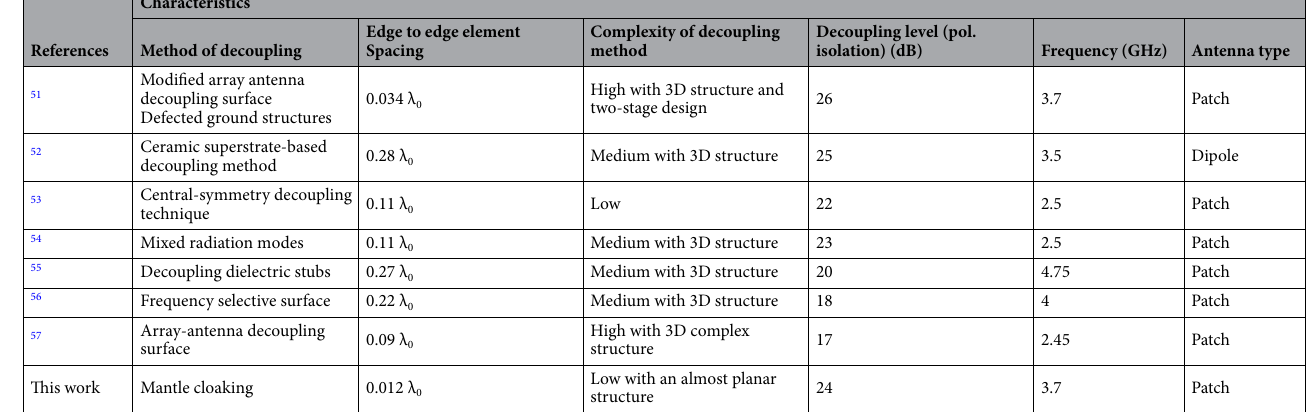
Table 3. Comparison between the present mantle cloaking method with other techniques used for decoupling the antennas.